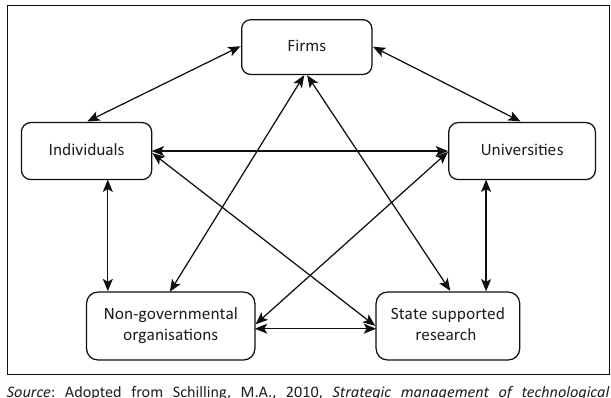
FIGURE 1: Sources of technological innovation as a system at a local